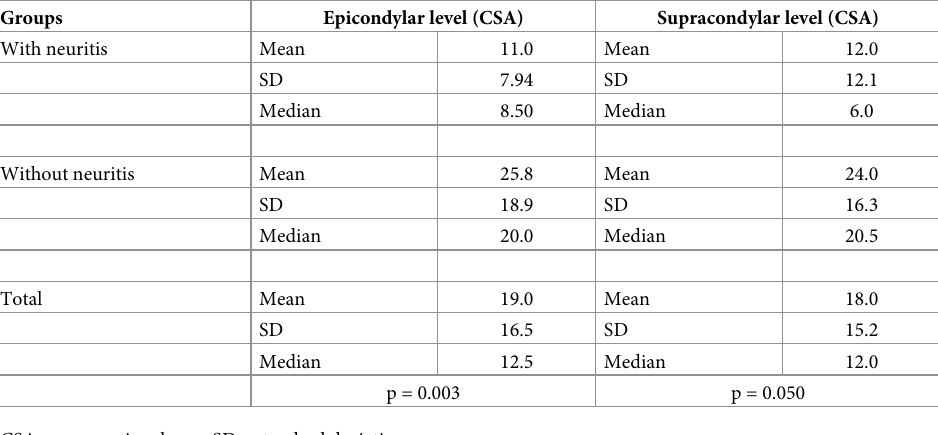
CSA–cross-sectional area; SD—standard